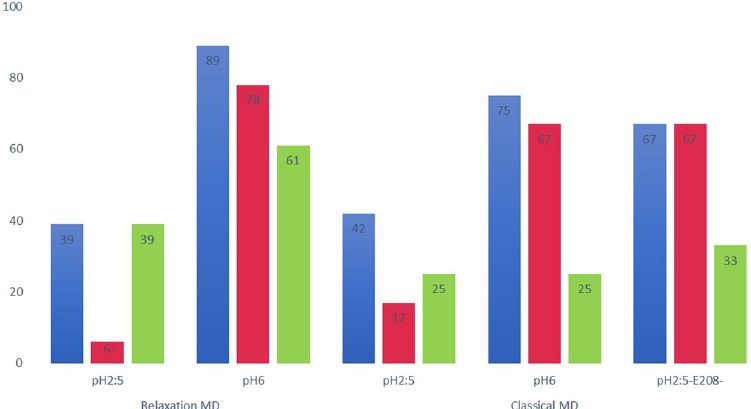
Figure 3. Percentages of ligand occupation in the binding site at the end of the simulations. Percentages of trajectories featuring Arg + (blue), Arg 2 + (red) or Agm 2 + (green) in the binding site at the end of the relaxation (left two clusters) and of the conventional MD simulations (right three